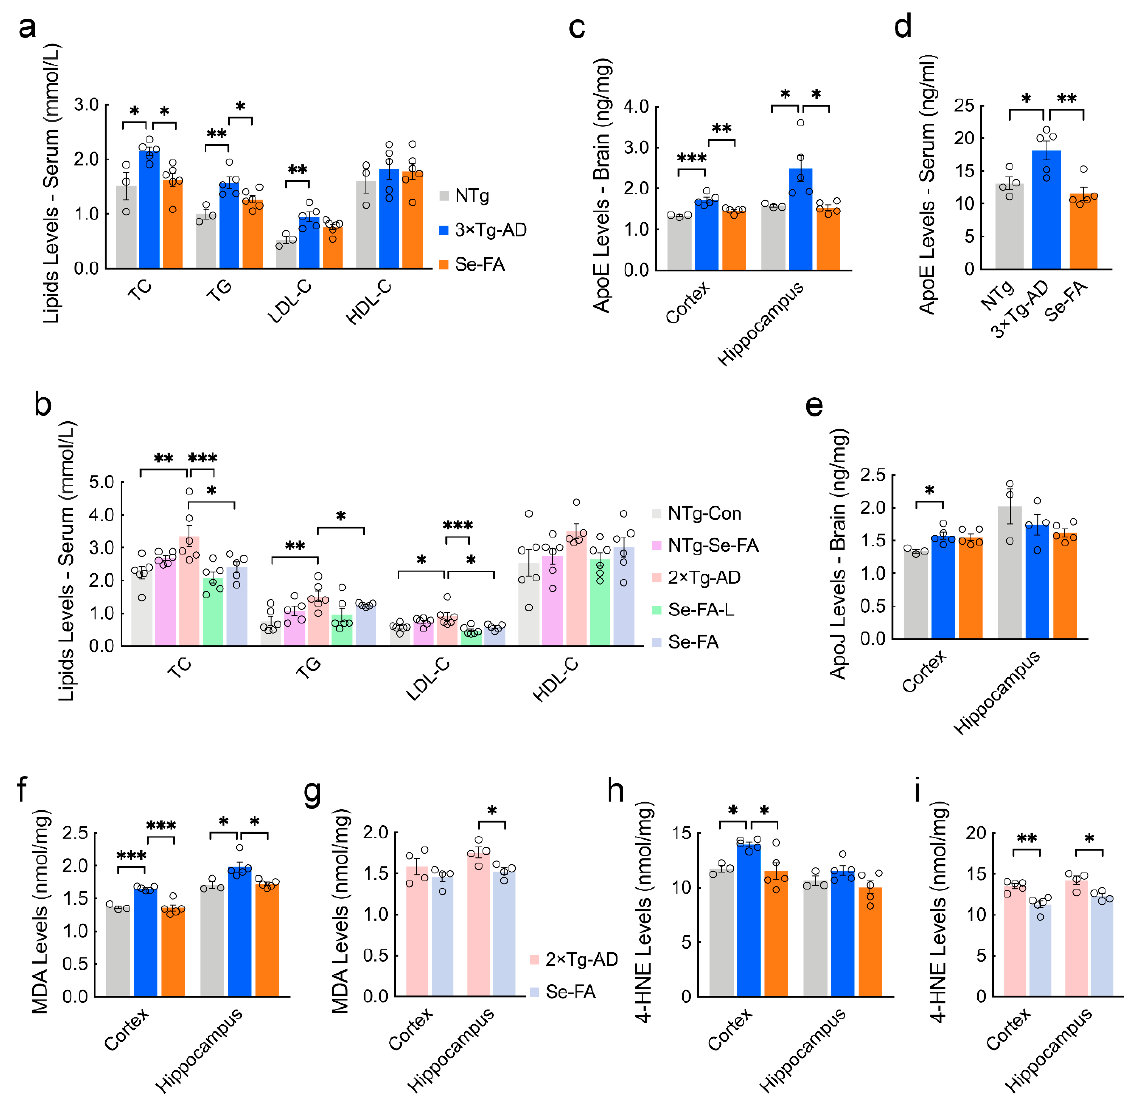
Figure 4. Se-FA reduces the levels of lipids, lipoproteins and MDA in the serum or brain of AD mice. ( a , b ) Levels of TC, TG, LDL-C, and HDL-C in the serum of 7-month-old 3×Tg- ( a ) and 2×Tg-AD mice ( b ) measured by an automated chemistry analyzer (n = 3 or 5 mice). ( c , d ) ApoE levels in the cortex ( c ), hippocampus ( c ) and serum ( d ) of 7-month-old 3×Tg-AD mice measured by ELISA (n = 3 or 5 mice). ( e ) ApoJ levels in the cortex and hippocampus of 7-month-old 3×Tg-AD mice measured by ELISA (n = 3 or 5 mice). ( f – i ) Levels of MDA ( f , g ) and 4-HNE ( h , i ) in the cortex and hippocampus of 3×Tg- ( f , h ) and 2×Tg-AD mice ( g , i ) measured by ELISA (n = 3, 4 or 5 mice). All the mice were fed diets with Se-FA or a control diet for 12 weeks. All data are presented as the mean ± SEM. * p < 0.05, ** p < 0.01, *** p < 0.001 as determined by one-way ANOVA followed by Dunnett’s multiple comparison test.